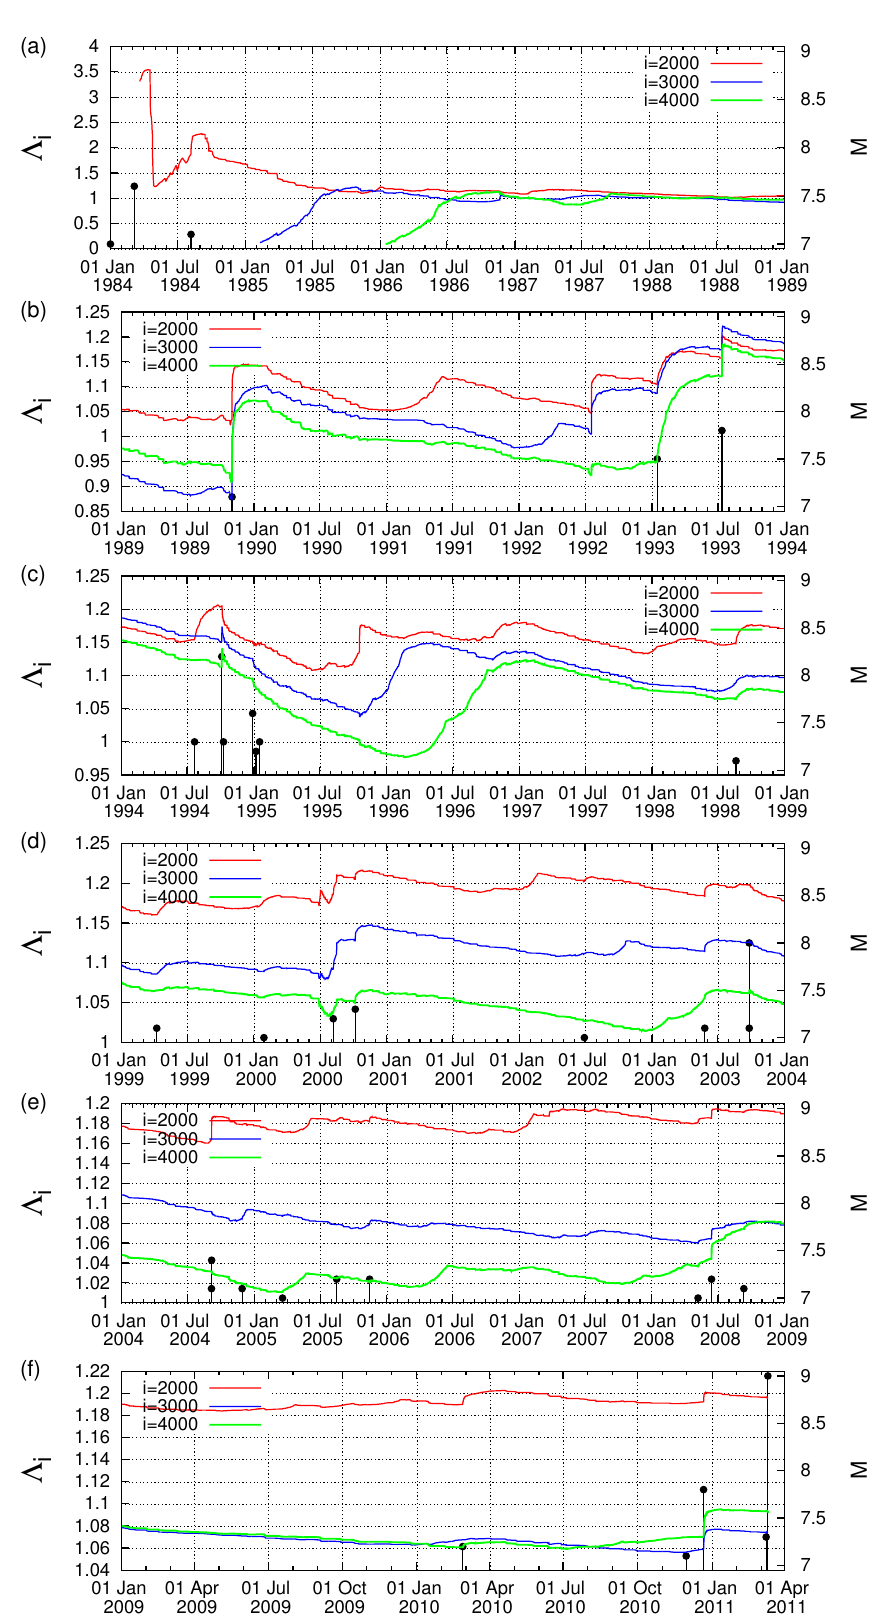
Figure 14. ( a – f ) The complexity measure Λ i versus the conventional time for the scales i = 2000 (red), 3000 (blue) and 4000 events (green) since 1 January 1984 until the M 9 Tohoku EQ occurrence on 11 March 2011. The vertical lines ending at black solid circles show the magnitudes ( M ≥ 7) of EQs, which are read in the right scale. Taken from Ref.